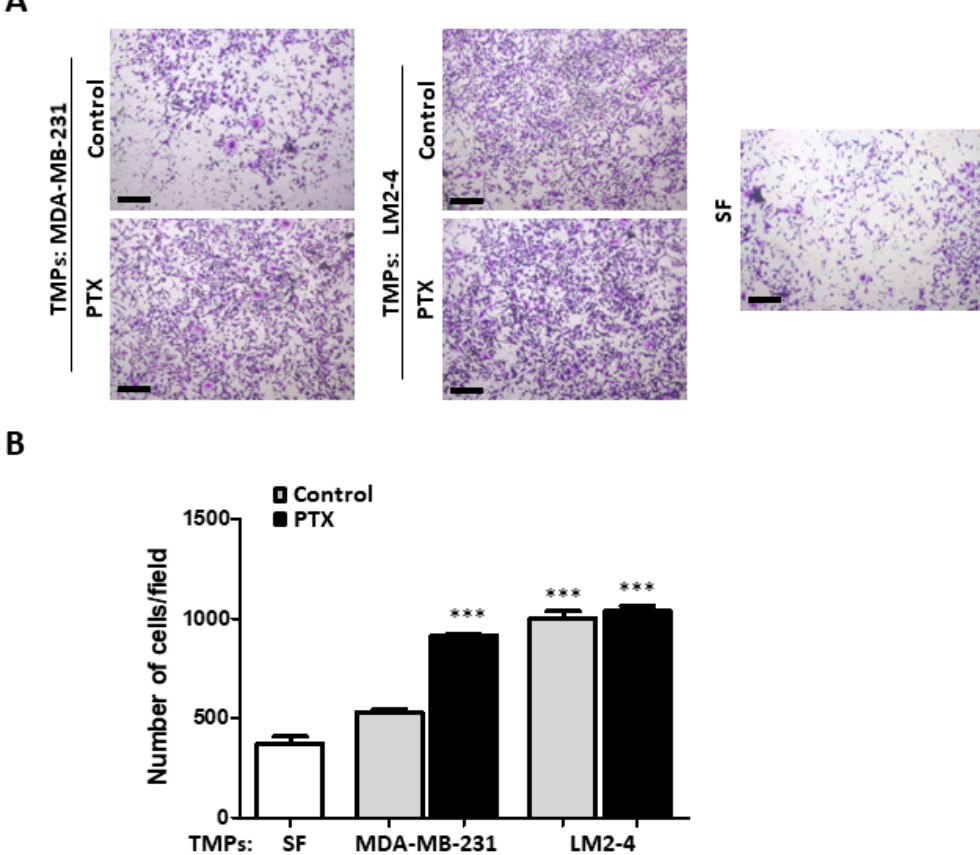
Figure 1. Tumor-derived microparticles (TMPs) from highly metastatic cells or cells exposed to chemotherapy increase cell invasion . ( A , B ) MDA-MB-231 cells cultured with serum-free medium or TMPs from MDA-MB-231 or LM2-4 cells exposed to paclitaxel (PTX) or vehicle control were assessed for invasion properties using the Boyden chamber assay. Representative images of invading cells are shown in ( A ). Scale bar, 200 µ m. Quantifications of invading cells are shown in ( B ) ( n = 5 repeats and 7 images / repeat). *, di ff erences compared to MDA-MB-231 control. ***, p < 0.001, as assessed by one-way ANOVA followed by Tukey post-hoc test.